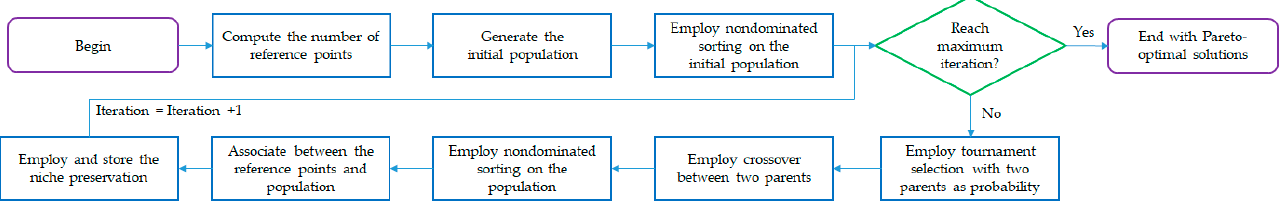
Figure 3. Workflow of the NSGA-III algorithm.